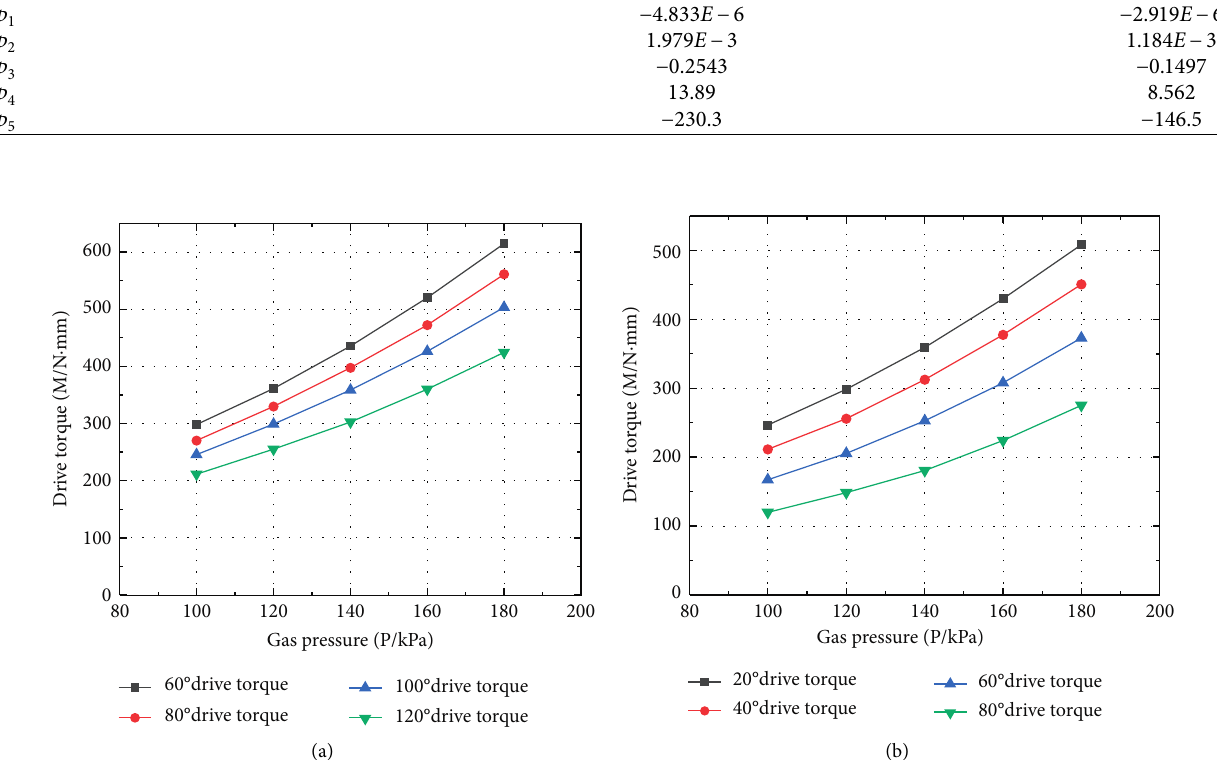
Figure 13: The P − M characteristic curve of pneumatic soft-bodied bionic basic units for fixed angle. (a) Unidirectional basic execution unit. (b) Bidirectional basic execution